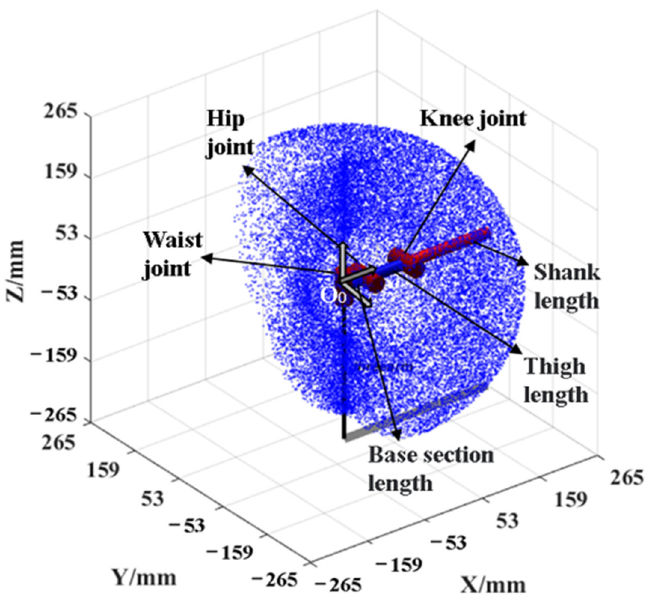
Figure 6. Workspace diagram of a robot leg.